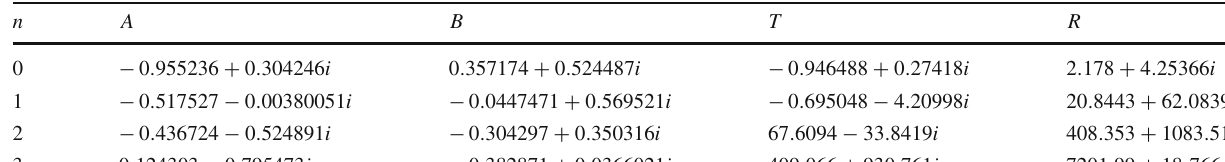
Table 4 Scattering coefficients for the wormhole states with E n = E n (cid:2) where n (cid:2) = − n − 1 , m (cid:2) = 1